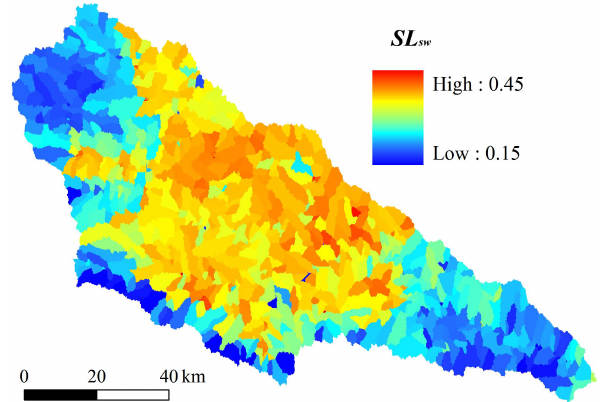
Fig. 8. Spatial distribution of the C-factor values for the sub- watersheds in the Yanhe watershed.